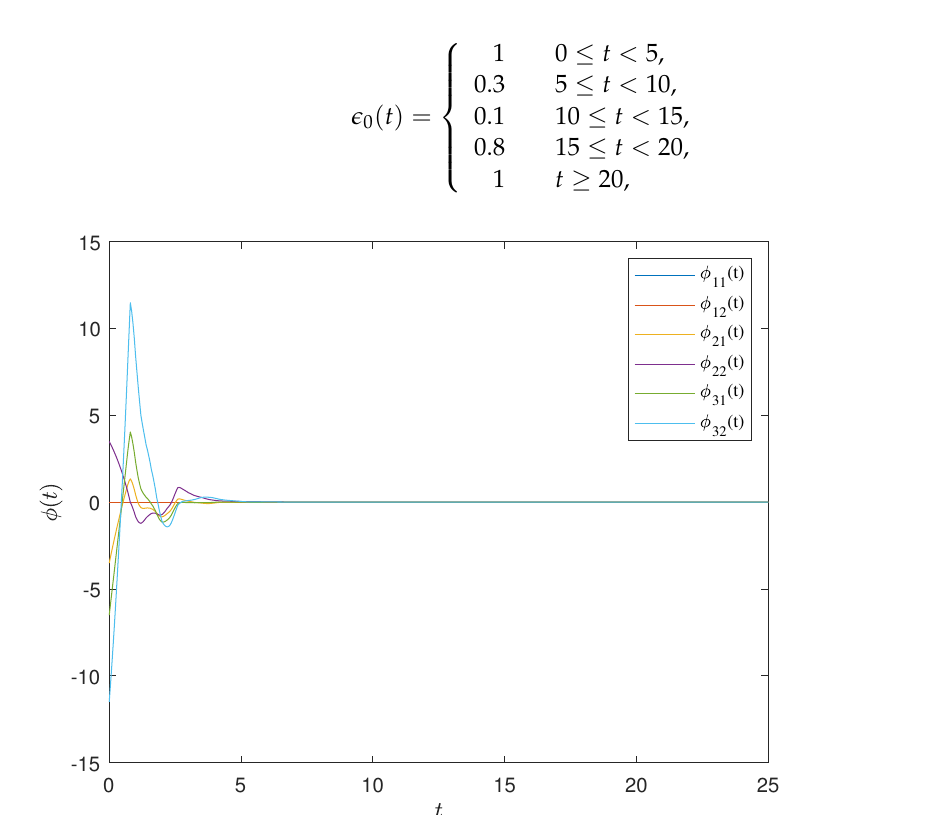
Figure 6. The state trajectory of the error system under the improved event-triggered control in Exam- ple 1. Under the designed improved event-triggered controller, the system achieved synchronization performance.